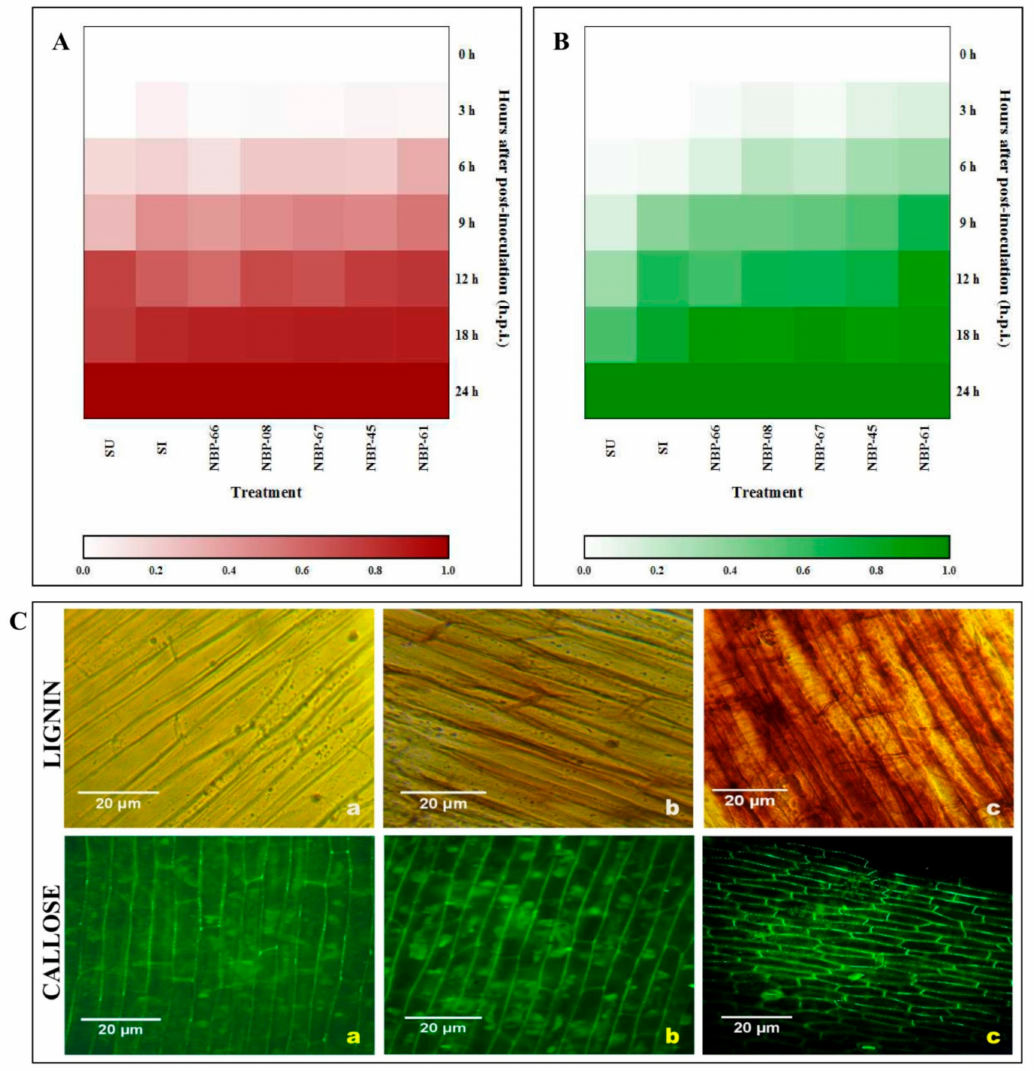
Figure 1. Lignin and callose deposition observed in the epidermal peelings of coleoptile regions of chilli seedlings treated with PGPF and challenge-inoculated with C. capsici. ( A , B ) Heat maps showing the pattern of the percentage of cells with lignin and callose deposition along the cell walls, respectively. ( C ) Representative light microscopic images showing the deposition of lignin and callose; a—susceptible uninoculated; b—susceptible inoculated; and c—NBP-61-treated and